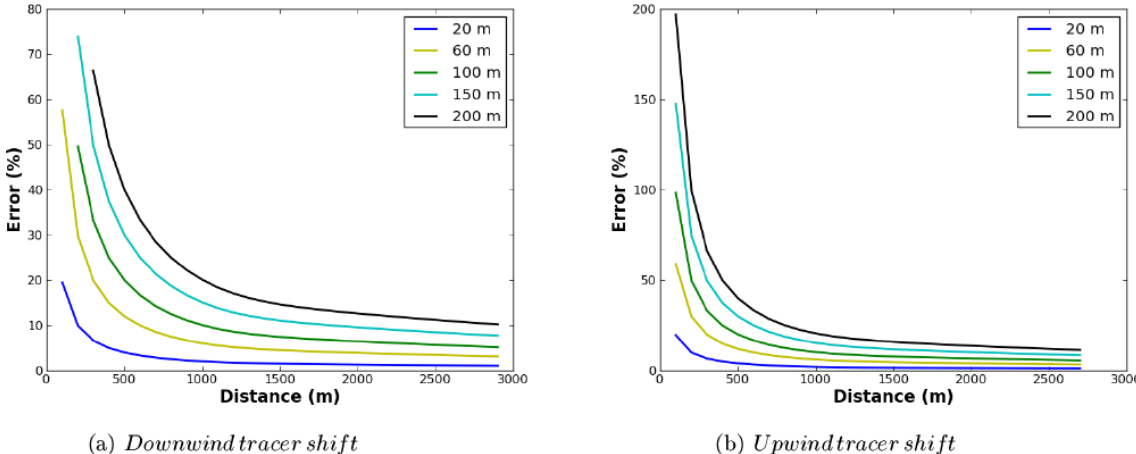
Figure 4. Error in plume estimation with the tracer method depending on the measurement distance to the methane source and a shift of 20, 60, 100 150 and 200m of the tracer location relative to the methane source using our Gaussian plume